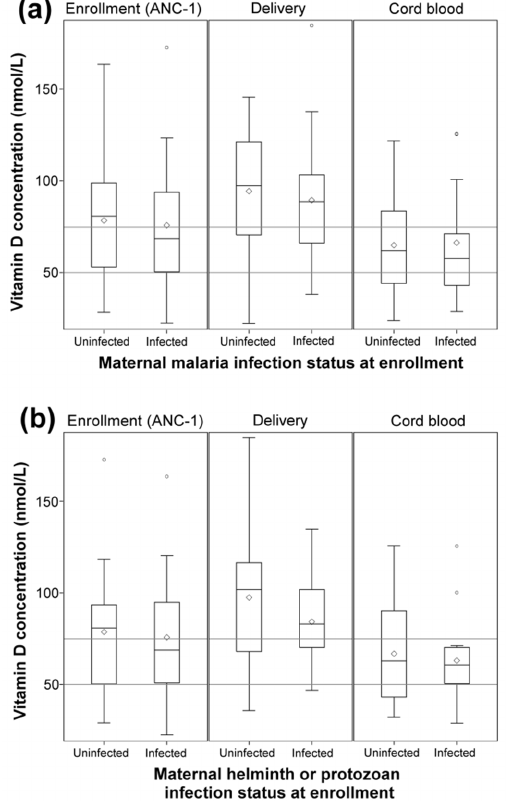
Figure 2. Maternal plasma 25(OH)D concentrations at enrollment (ANC-1), delivery (in venous), and cord blood by ( a ) maternal peripheral malaria infection at enrollment status; and by ( b ) maternal helminth or protozoan infection status at enrollment. Maternal malaria infection status was based on qPCR diagnosis at enrollment. Means were compared using t -test with significance set at p ≤ 0.05. Horizontal lines show plasma 25(OH)D levels for insufficiency (<75 nmol/L) and deficiency (<50